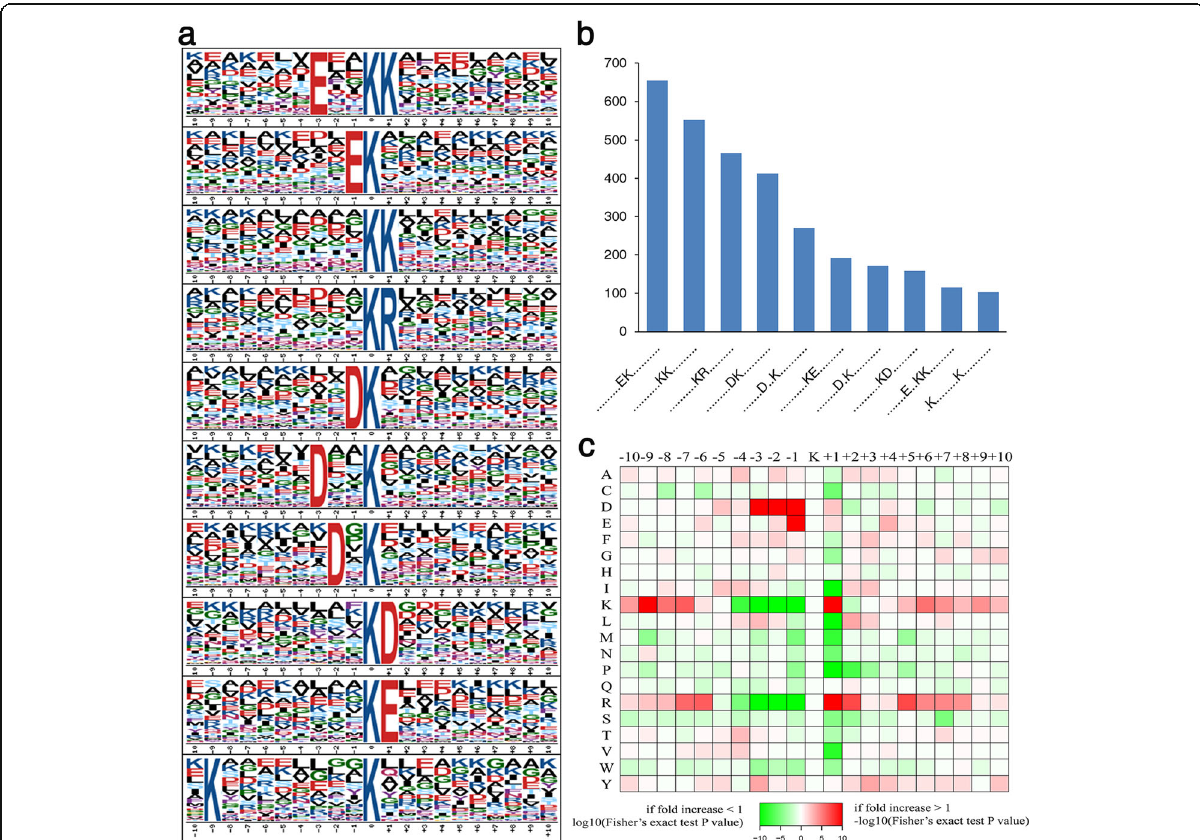
Fig. 2 Motif analysis of all identified Khib sites. a Conserved motifs identified around the Khib sites. The size of each letter reflects the frequency of that amino acid residue in that position. b Frequency for each motif occurring in peptides with Khib modification. c Heat-map of the amino acid compositions of the Khib sites, showing the enrichment (red) and depletion (green) of amino acids in each position (from − 10 to + 10) flanking the Khib